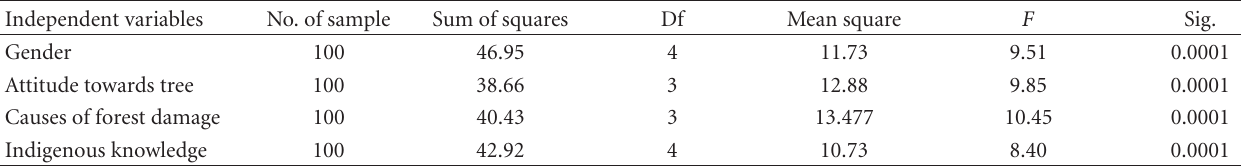
Table 2: Comparisons of means for the selected variables a ff ect the dependent variable (respondents’ attitude towards community forestry). Independent variables No. of sample